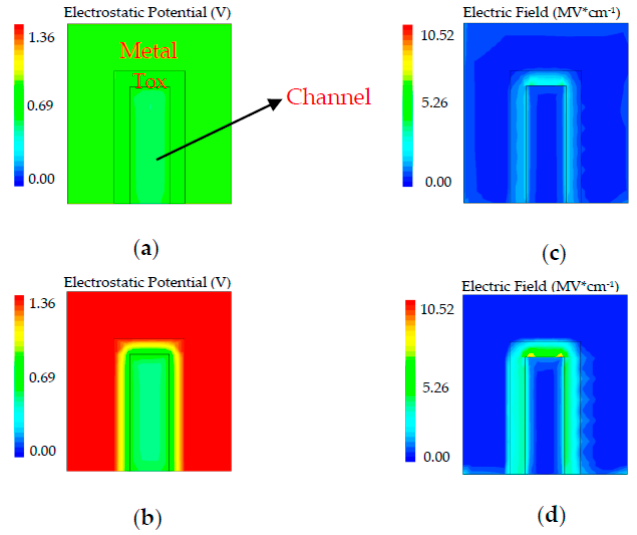
Figure 6. Electrostatic potential ( a , b ), and electric field ( c , d ) in the DMG JL FinFET at L 1 / L = 0.4 near the source ( a , c ) and drain ( b , d